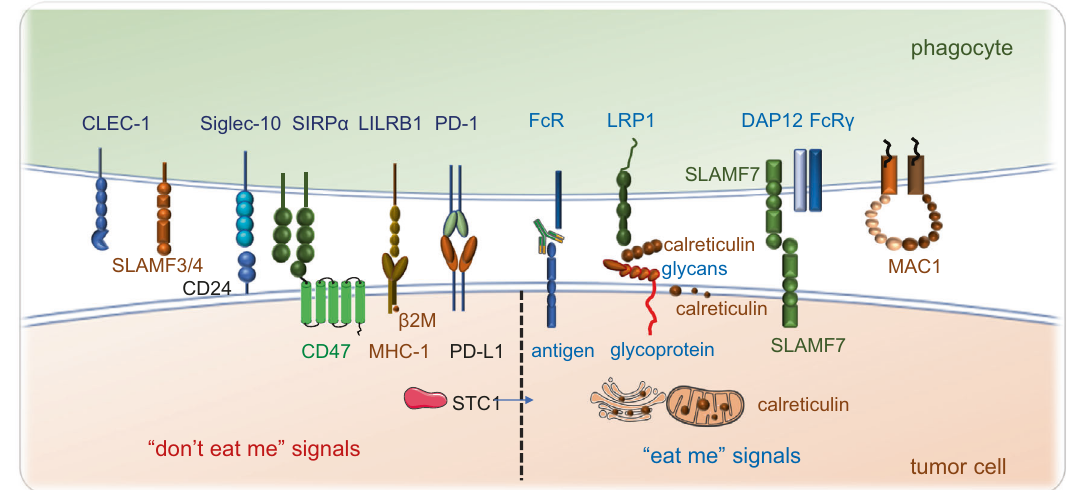
Fig. 2 Phagocytosis checkpoints in cancer immunotherapy. Phagocytosis of tumor cells by macrophages is regulated by many “ eat me ” (pro- phagocytosis) and “ don ’ t eat me ” (anti-phagocytosis) signals. The expression of “ don ’ t eat me ” signals on tumor cells including CD47, CD24, PD-L1, MHC-I and STC-1 protect tumor cells from phagocytic clearance by interacting with their receptors on phagocytes. The working pathways are CD47-SIRP α , CD24-Siglec-10, MHC-1(B2M)-LILRB1, and PD-L1-PD-1. The high expression of tumor STC-1 traps the calreticulin in mitochondria and ER thus reducing the quantity of calreticulin on the cell surface, impairing phagocytosis and antigen processing and presentation, also leading to weak T cell response. Other anti-phagocytosis receptors such as SLAMF3, SLAMF4, Fc γ RIIB, and CLEC-1 facilitate the phagocytosis of tumor cells by phagocytes. The “ eat me ” signals such as calreticulin bind with the membrane glycans and are located on the cancer cell surface. It interacts with the lipoprotein receptor-related protein 1 (LRP1) receptor present on phagocytes. It seems that SLAMF7 expressed on tumor cells and MAC-1 on macrophages are both critical for inducing tumor phagocytosis, while the clear mechanism of SLAMF7-induced phagocytosis is under